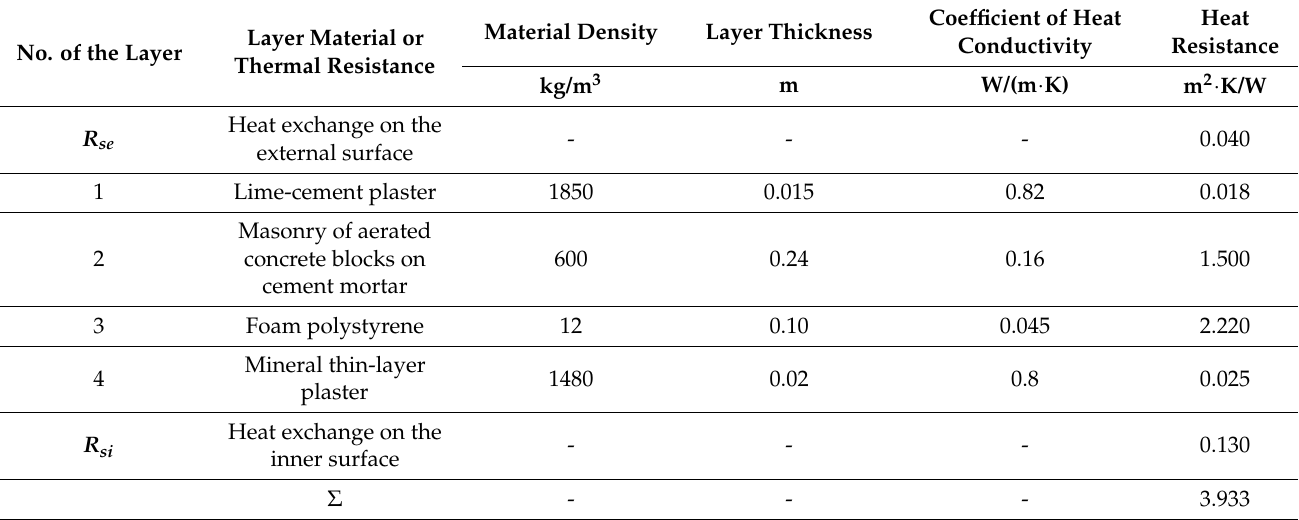
Table 1. Indicators of thermal protection of the external wall